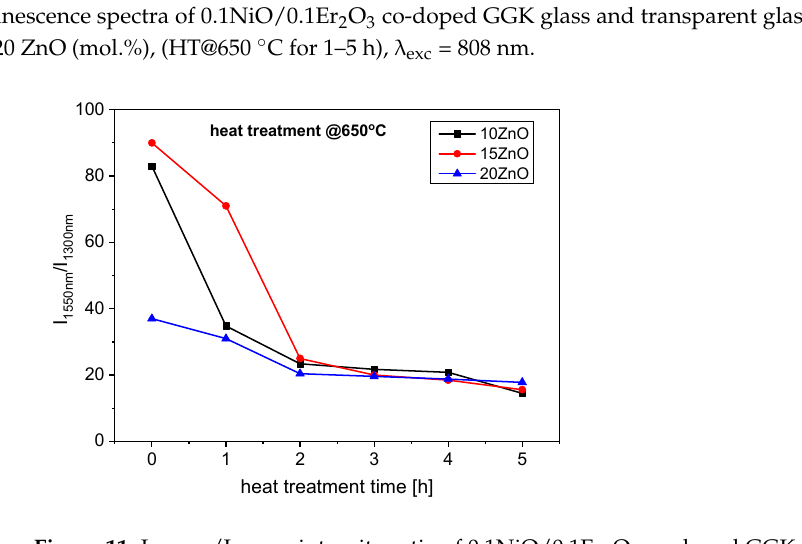
Figure 11. I 1550nm /I 1300nm intensity ratio of 0.1NiO/0.1Er 2 O 3 co-doped GGK glass and transparent glass-ceramics with 15 ZnO (mol.%), 20 ZnO (mol.%), (HT@650 °C for 1–5 h), λ exc = 808 nm.